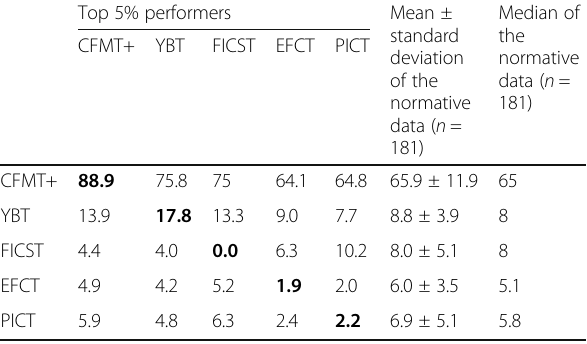
Table 6 Top performers mean performance for each of the five administered